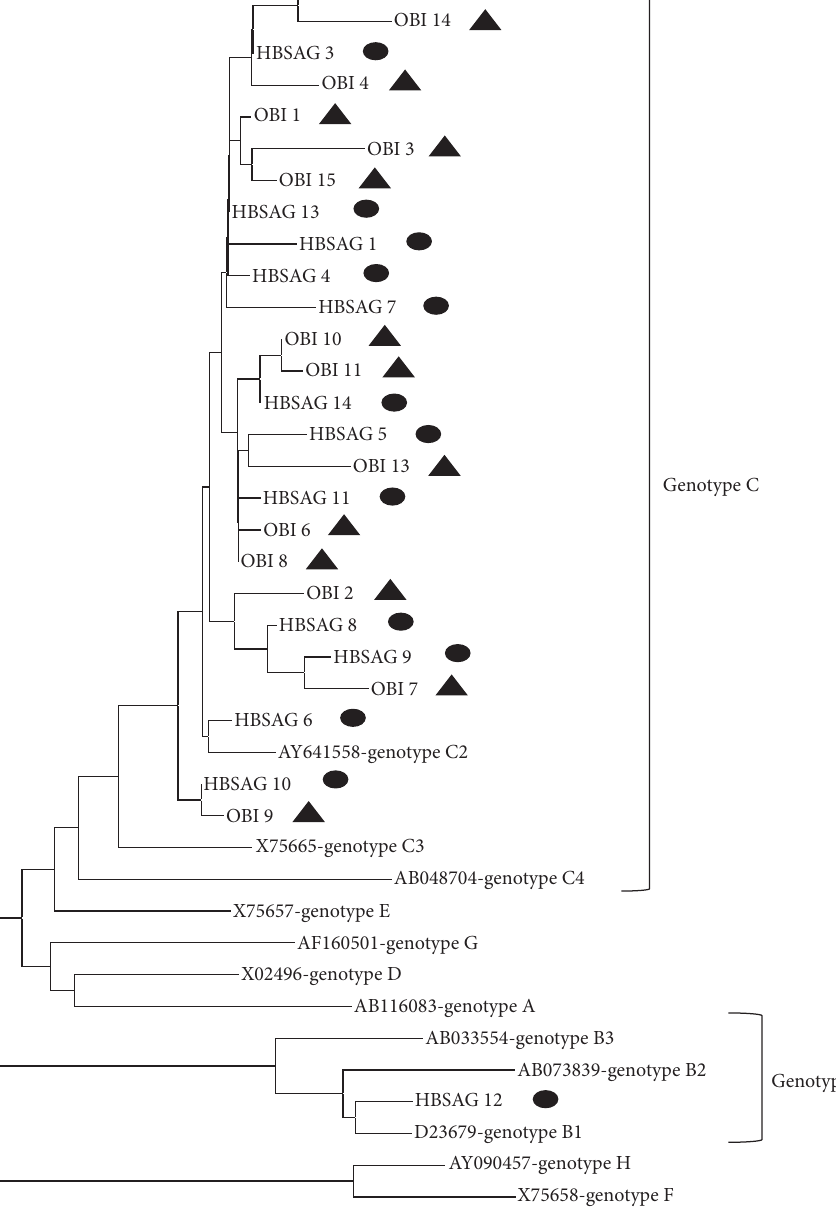
Figure 2: Phylogenetic tree analysis of the S gene sequences of strains isolated in this study. TheHBV strains fromdifferent genotypes (A to H) are obtained from GenBank. The GenBank HBV sequences are indicated with their accession number followed by genotypes. The sequences determined in this study are indicated by isolate number, starting with HBSAG or OBI, and are labelled with black circles and triangles for HBsAg-positive patients and patients with occult HBV infection,